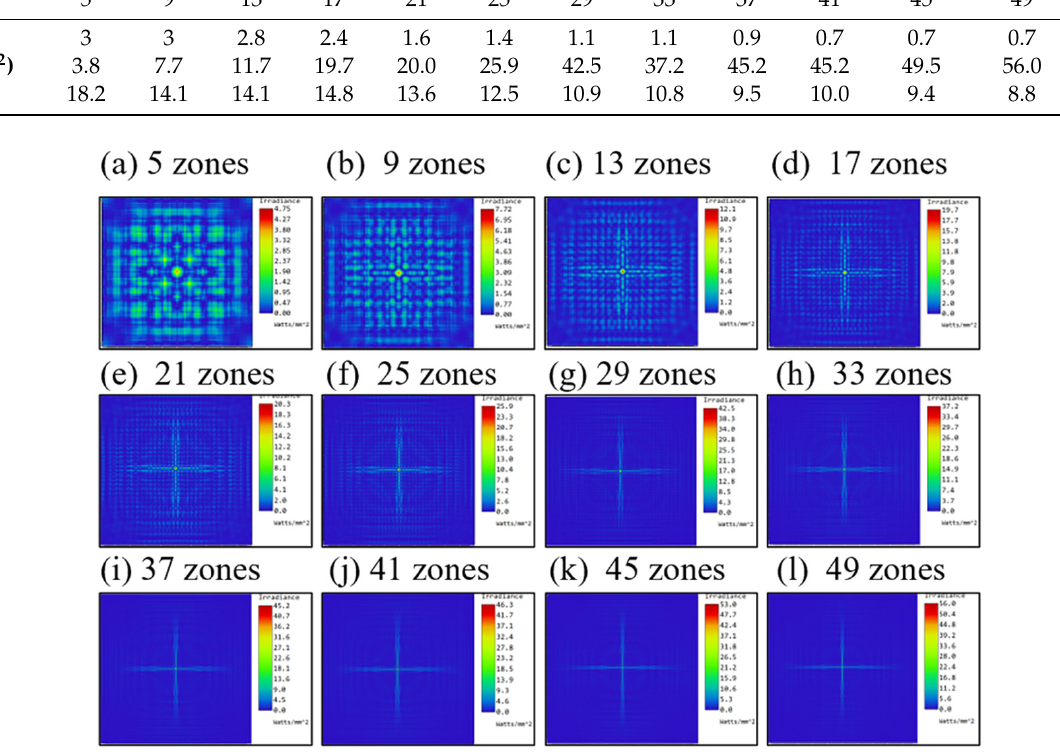
Table 1. Comparison of diffraction properties of S-FZPs with different zone numbers.